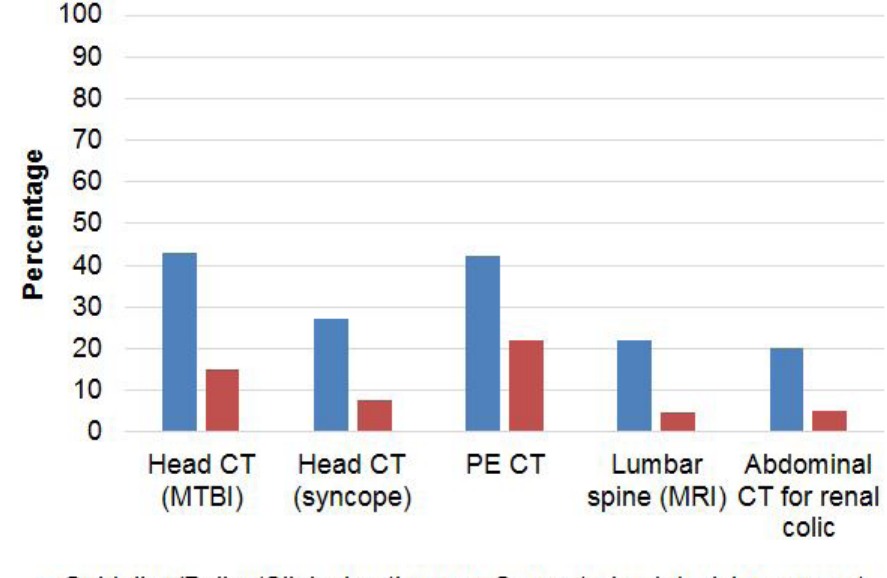
Figure 2. Interventions for Choosing Wisely clinical scenarios. CT, computed tomography; MTBI, mild traumatic brain injury; PE, pulmonary embolism; MRI, magnetic resonance